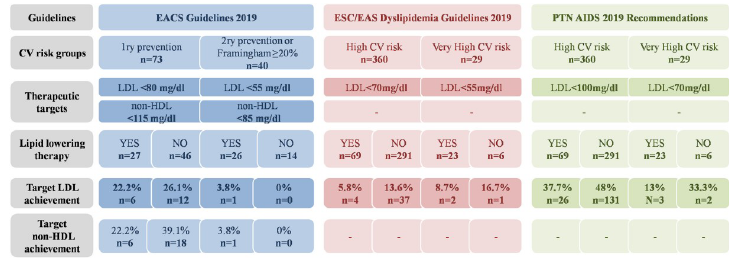
Fig 4. The achievement of therapeutic goals stated in EACS Guidelines 2019, ESC/EAS Dyslipidemia Guidelines 2019 and PTN AIDS Guidelines 2019 with regard to lipid lowering therapy. In the high cardiovascular risk group without lipid lowering therapy 18 patients did not have LDL